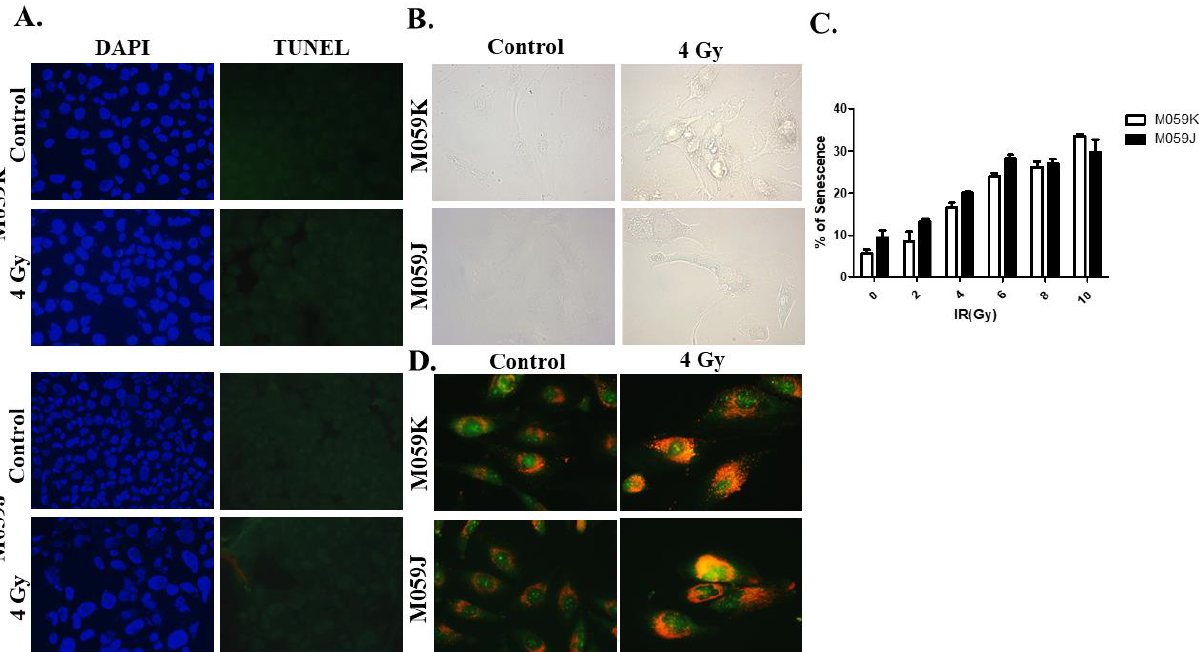
Figure 2. Promotion of autophagy and absence of senescence and apoptosis upon exposure to radiation in M059K and M059J cells. ( A ). Cells were treated with a dose of 4 Gy and stained with DAPI (left) and TUNEL (right) to determine the portion of cells that undergo apoptosis upon radiation. Irradiated cells (bottom) images show no TUNEL-positive cells in both cell lines suggestive of minimal apoptosis induction. ( B ). SA- β -galactosidase upregulation was monitored in M059K and M059J cells to evaluate senescence markers post-radiation. Images show minimal expression of SA- β -galactosidase in both cell lines. ( C ). Quantification of senescence in M059K and M059J cells by flow cytometry-based measurement of the SA- β -galactosidase fluorogenic surrogate C 12 FDG. ( D ). Both cell lines were exposed to 4 Gy and stained with acridine orange 72 h post-treatment. Treated cells showed increased accumulation of acidic vacuoles and enlargement of cell morphology. All